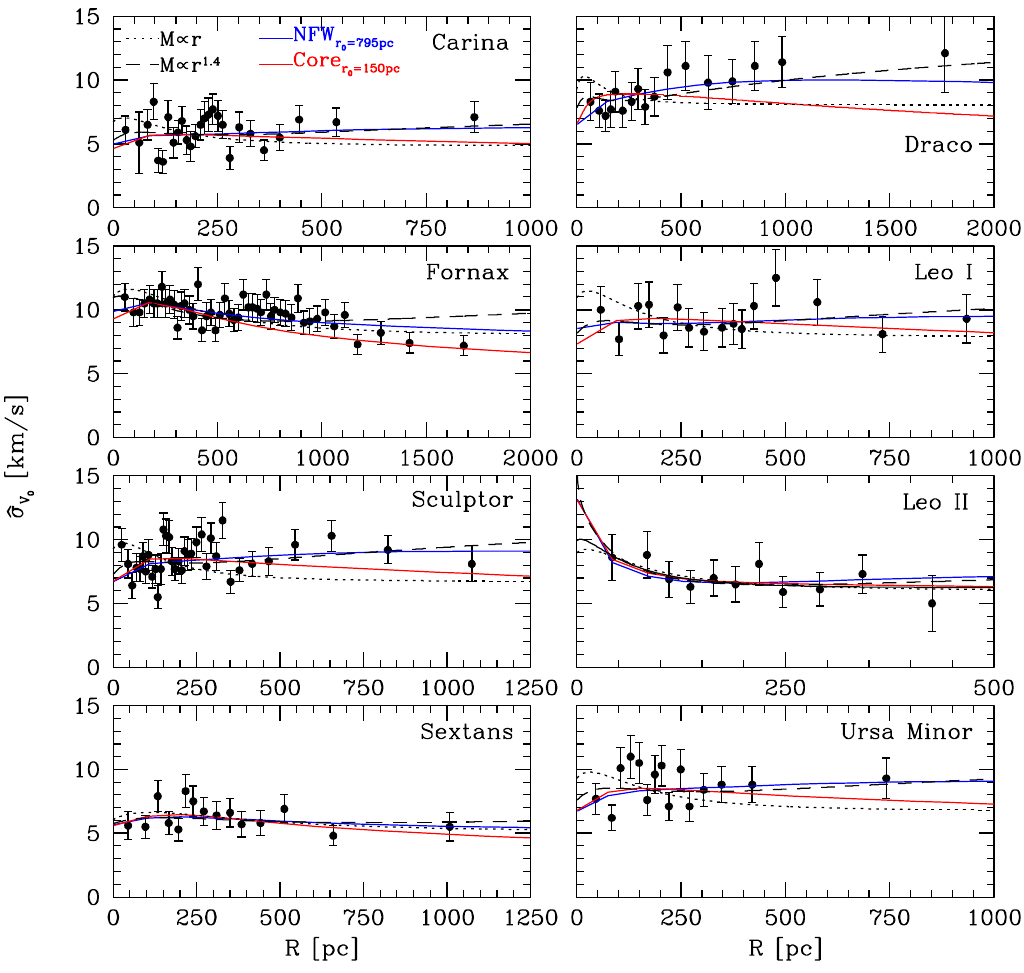
Figure 6. Projected velocity dispersion profile of the eight brightest dwarf satellites of the Milky Way. The red lines represent the best fit of the dark-matter density distribution with a core, while the blue ones derive from a cuspy profile. The long-dashed and dotted lines show the isothermal and power law models, respectively. The figure is reproduced from